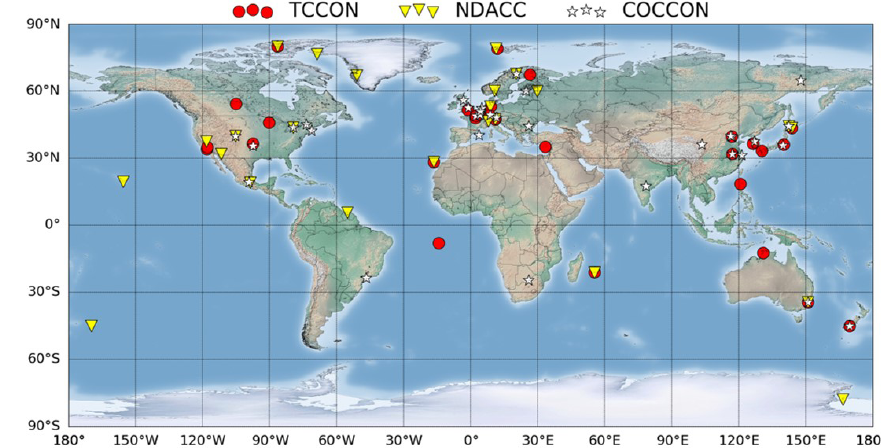
Figure 3. Global FTIR observation networks, including TCCON, NDACC-IRWG, and COCCON networks. Geolocations of all sites are listed in Table S2 in the Supplement. Base map of this figure is from the Basemap package of